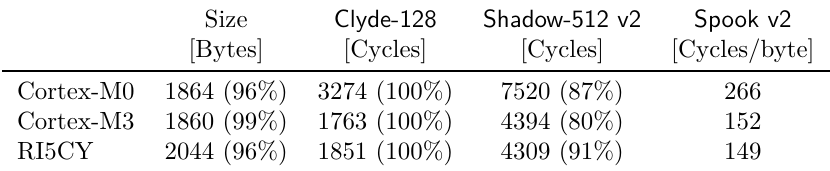
Table 16: Size-optimized performances on embedded platforms (-Os). The percentages are the comparison with the Spook v1 corresponding